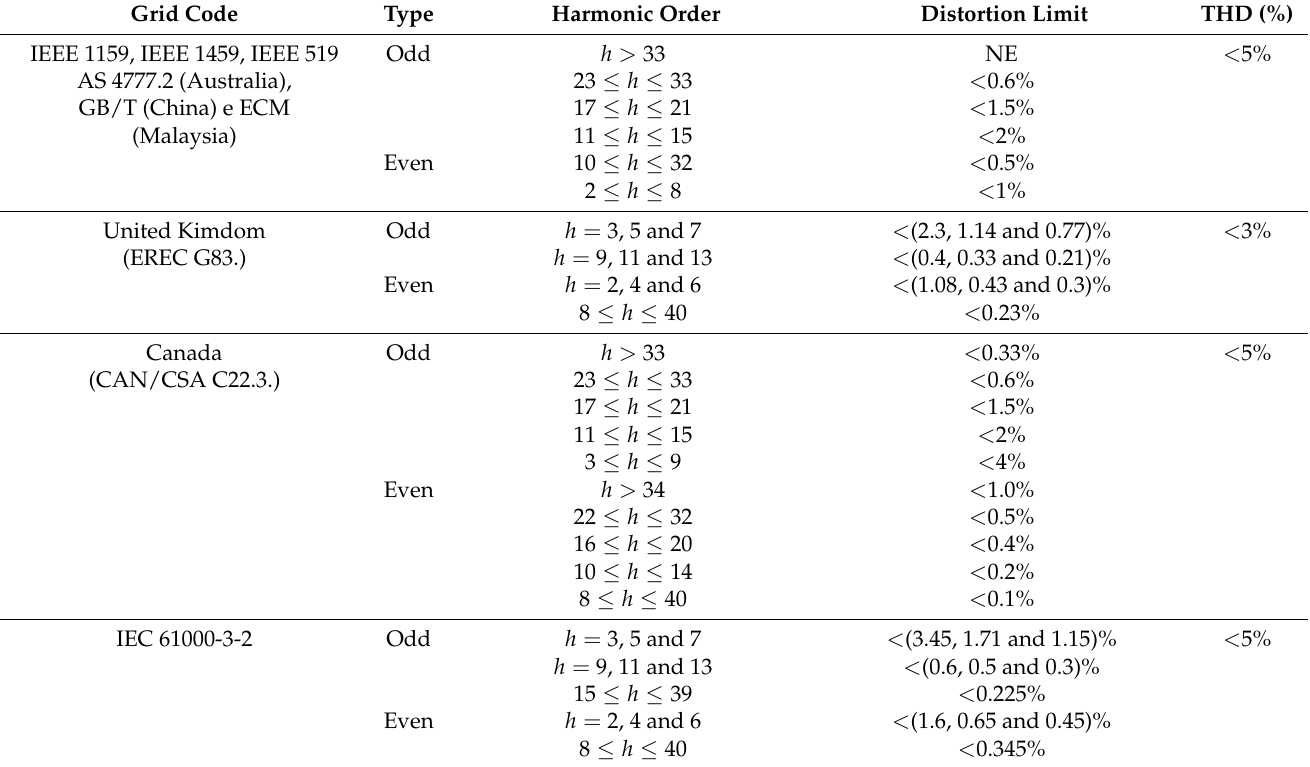
Table 7. Limits of harmonic distortion according to different